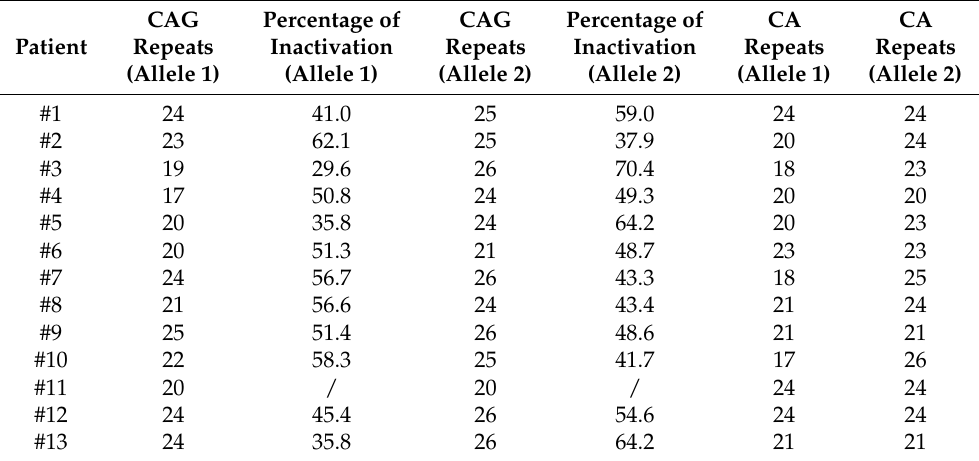
Table 3. Polymorphisms of the androgen receptor (CAG repeats) and estrogen receptor beta (CA repeats). For androgen receptor, percentage of X inactivation is